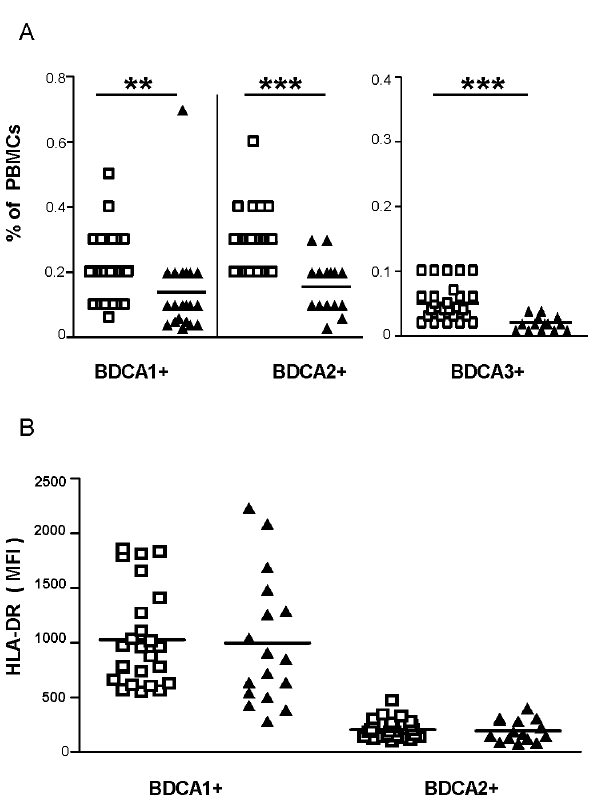
Figure 2. Cell frequencies and activation markers of circulating DCs (BDCA-1 + , BDCA-2 + , and BDCA-3 + ). Peripheral blood mononuclear cells (PBMCs) from the study participants were stained with monoclonal antibodies for subsequent flow cytometric analyses. mDCs (BDCA-1 + and BDCA-3 + DCs) as well as pDCs (BDCA-2 + DCs) were gated as described in Materials and Methods. Lower frequencies of circulating DCs were observed in TOSV-infected patients ( A ) with no difference in the expression levels of human leukocyte antigen (HLA) class II molecules compared to healthy controls ( B ). White squares indicate healthy controls and black triangles indicate TOSV-infected patients. N = 21 TOSV+ patients and n = 26 healthy controls were analyzed. MFI, mean fluorescence intensity. Data were analyzed using the non-parametric Mann–Whitney U test. ** indicates p ≤ 0.01 and *** indicates p ≤ 0.001.